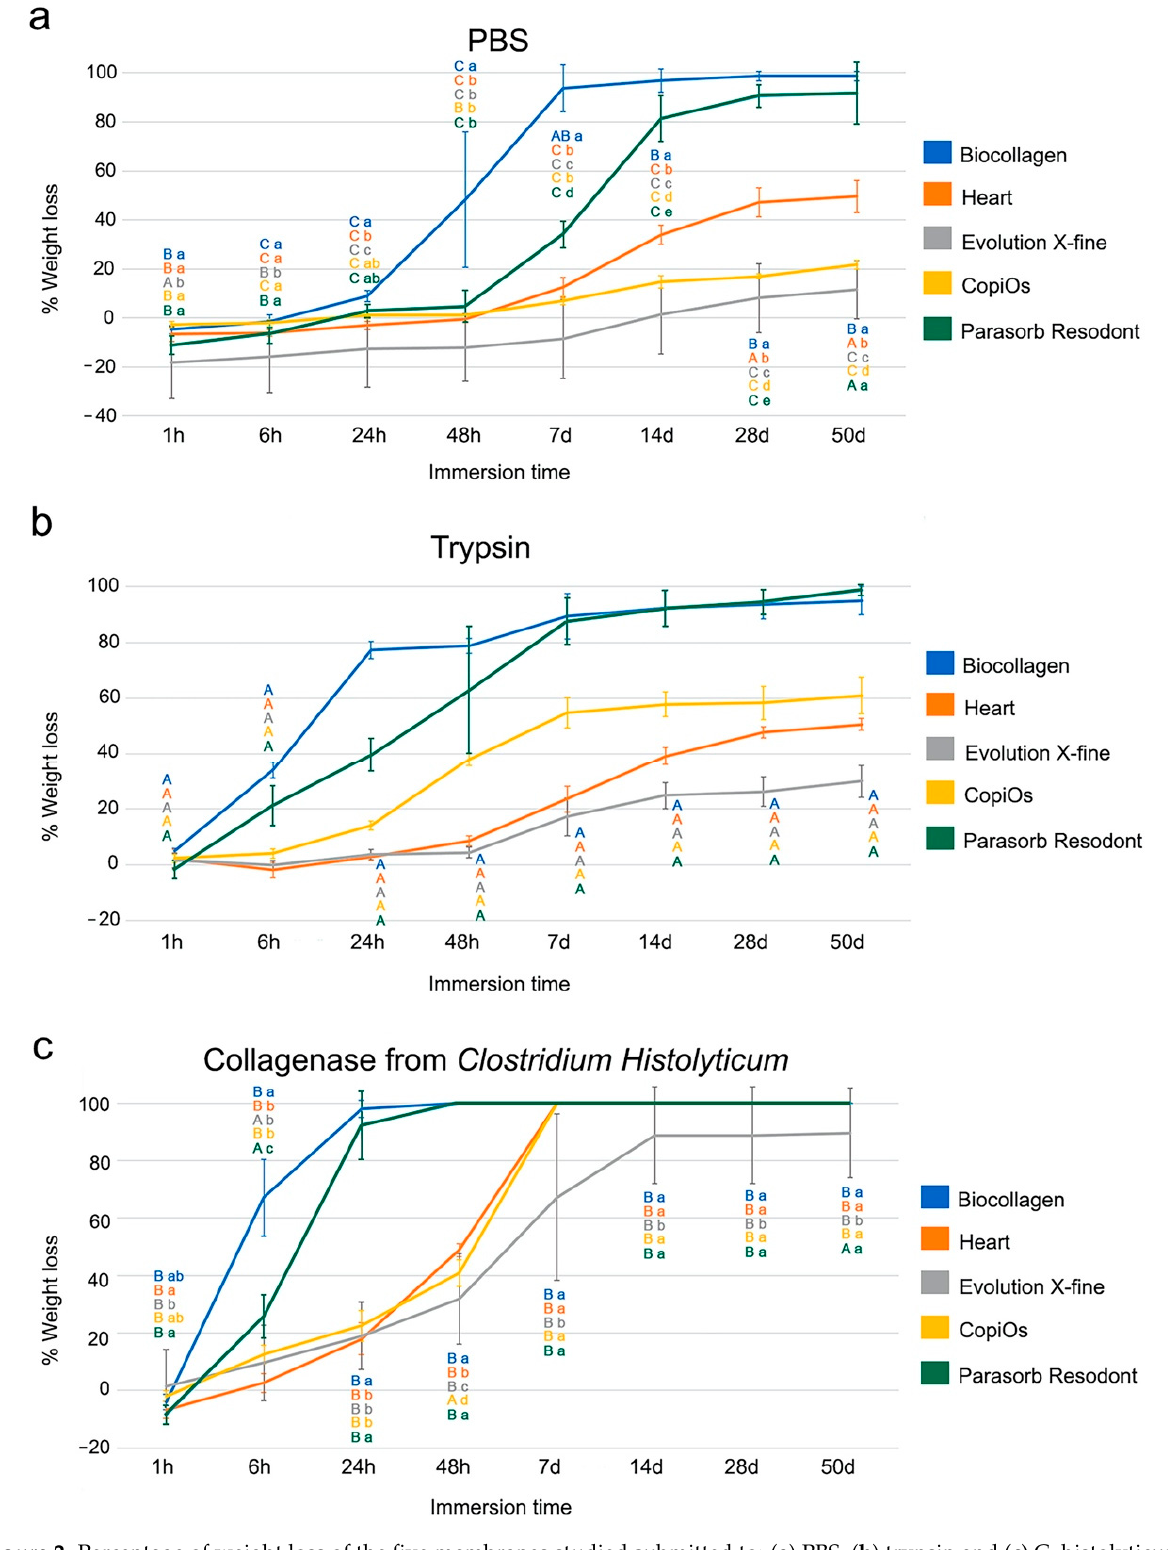
Figure 2. Percentage of weight loss of the five membranes studied submitted to: ( a ) PBS, ( b ) trypsin and ( c ) C. histolyticum collagenase over different time-points. Values expressed as mean and standard deviation. Significant differences among membranes are shown with lowercase letters and with capital letters for differences between degradation tests within the same membrane. Student-Newman-Keuls tests were performed for multiple comparisons ( p < 0.05).